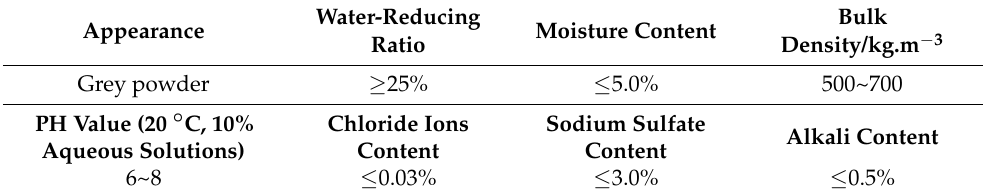
Table 2. Properties of the polycarboxylic superplasticizer.